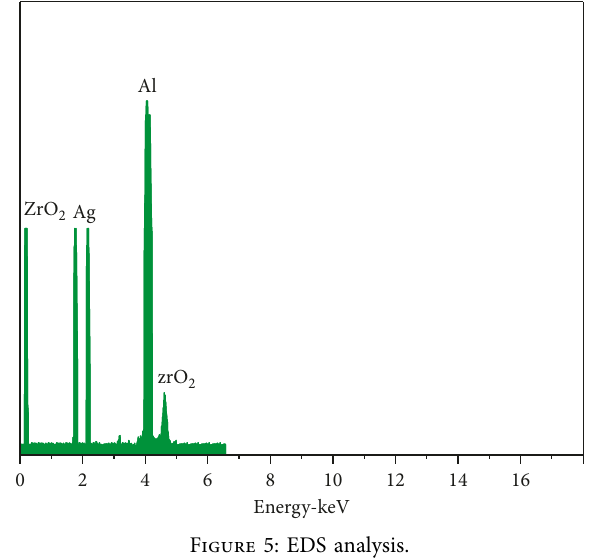
Figure 5: EDS analysis.